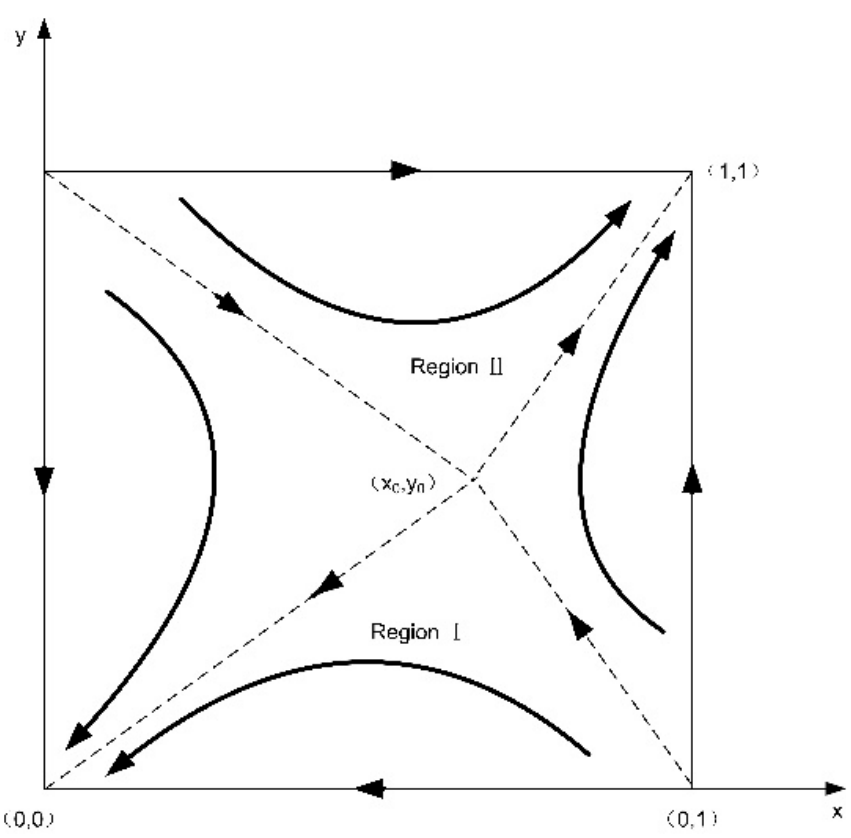
Figure 3. The dynamic evolutionary path of the strategy chosen by cloud providers and enterprises.